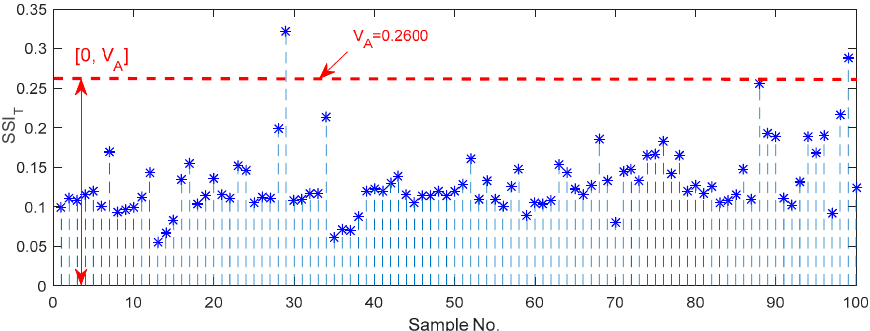
Figure 9. Upper and lower boundaries of the SSI T for quantification of normal axle bearing vibration signals.